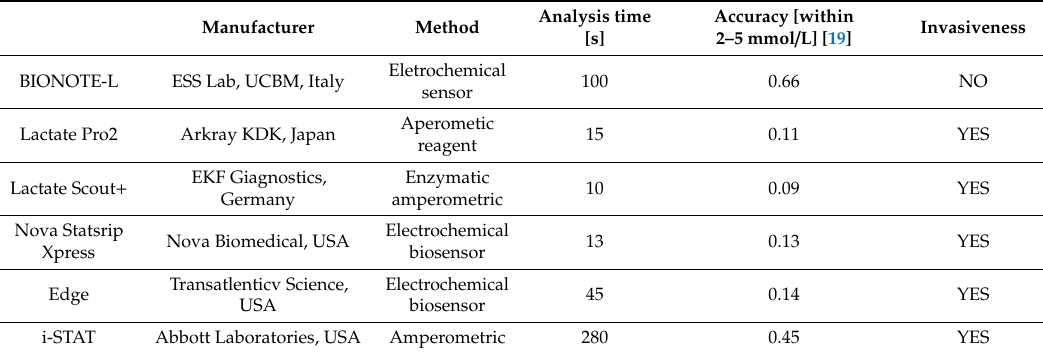
Table 4. Comparison chart of the proposed device and five commercial portable devices